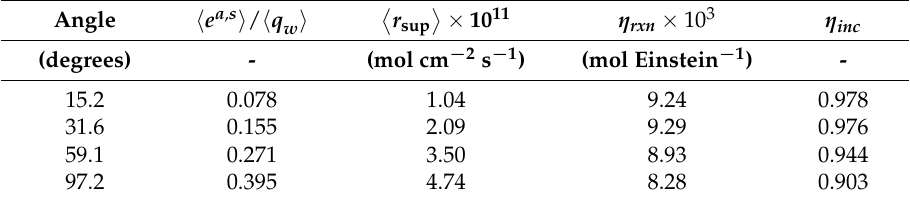
Table 3. Results of efficiencies for different folding angles. Adapted with permission from Passal í a, C.; Alfano, O.M.; Brandi, R.J. Optimal design of a corrugated-wall photocatalytic reactor using efficiencies in series and computational fluid dynamics (CFD) modeling. Ind. Eng. Chem. Res. 2013 , 52 , 6916–6922. Copyright 2013 American Chemical Society